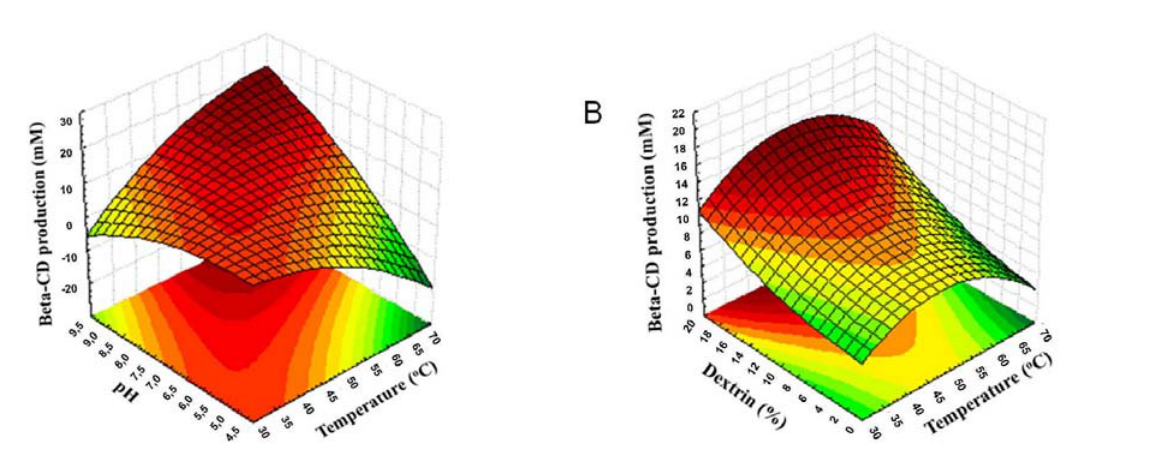
Figure 3. Statistical optimization of β -CD production using RSM. ( A ) pH and temperature; ( B ) dextrin and temperature; ( C ) dextrin and pH; and ( D ) normal probability plot of